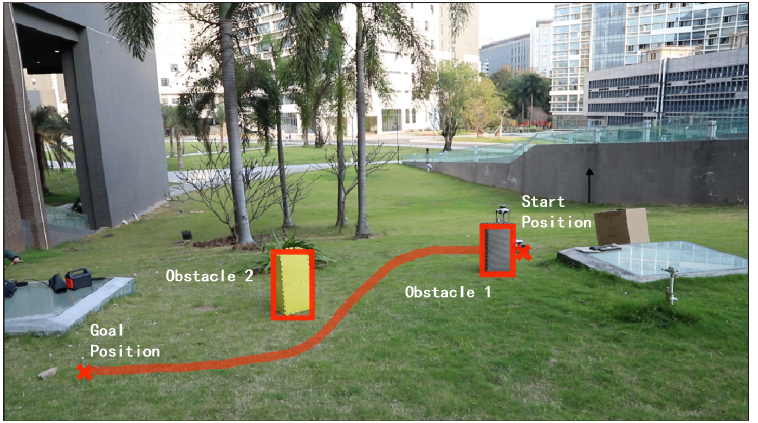
Figure 7. The robot’s path in Exp 2 resulting from the integrated improved A (cid:63) algorithm and Q -learning algorithm.